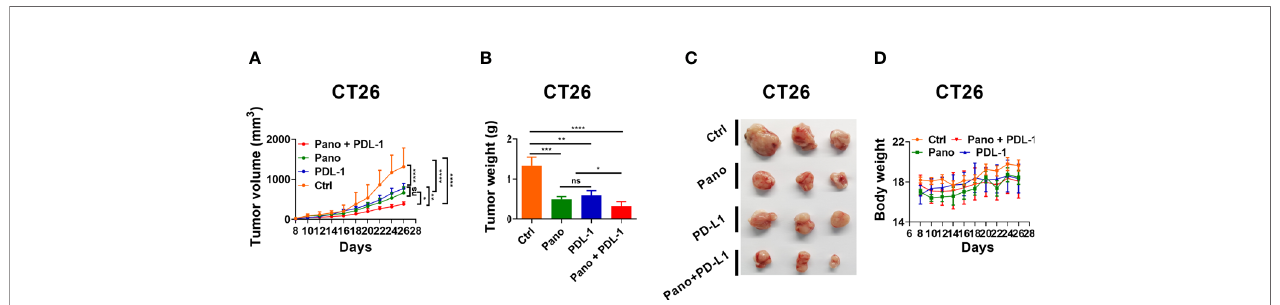
FIGURE 6 | HDACi (Panobinostat) synergizes with anti-PDL-1 therapy. Evaluation of tumor growth kinetic for anti-PDL-1 and Panobinostat therapy (Tumor growth curve, Tumor weight, Tumor images, and Bodyweight at the end of the experiment). (A – D) Tumor growth kinetic for BALB/c mice inoculated with CT26 (2 X 10 5 cells/mice). Statistical signi fi cance was assessed by t-test. (not signi fi cant ns, P > 0.05, *P ≤ 0.05, **P ≤ 0.01, ***P ≤ 0.001, ****P